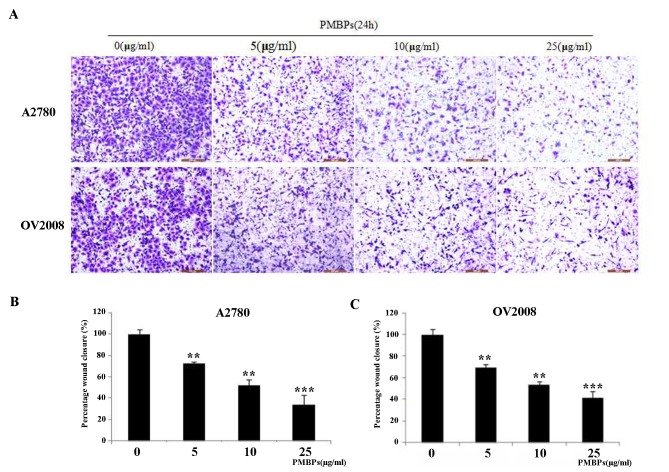
PMBPs impaired the migration and invasion of ovarian cancer cells as assessed by transwell chamber assay.A2780 and OV2008 cells were treated with PMBPs (0, 5, 10, 25 μg/ml) for 24 h. (A) Representative images of cells that migrated and invaded onto the underside of transwell membrane at 100× magnification under a microscope. (B,C) Number of cells of each field was counted and averaged. Invaded cells were expressed relative to that of control group. The experiments were repeated three times. **P<0.01 and ***P<0.001 compared to the control group.